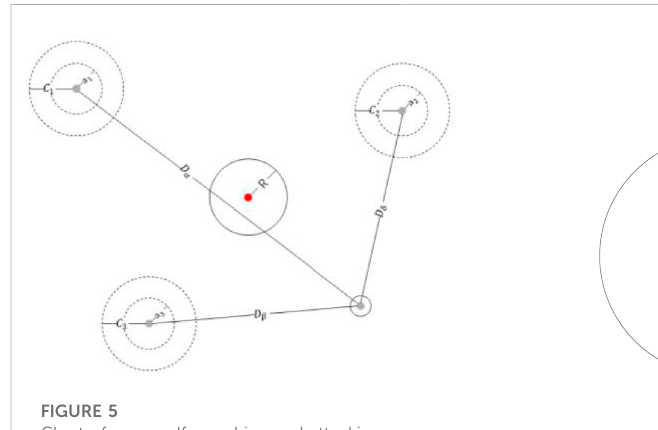
FIGURE 5 Chart of grey wolf searching and attacking